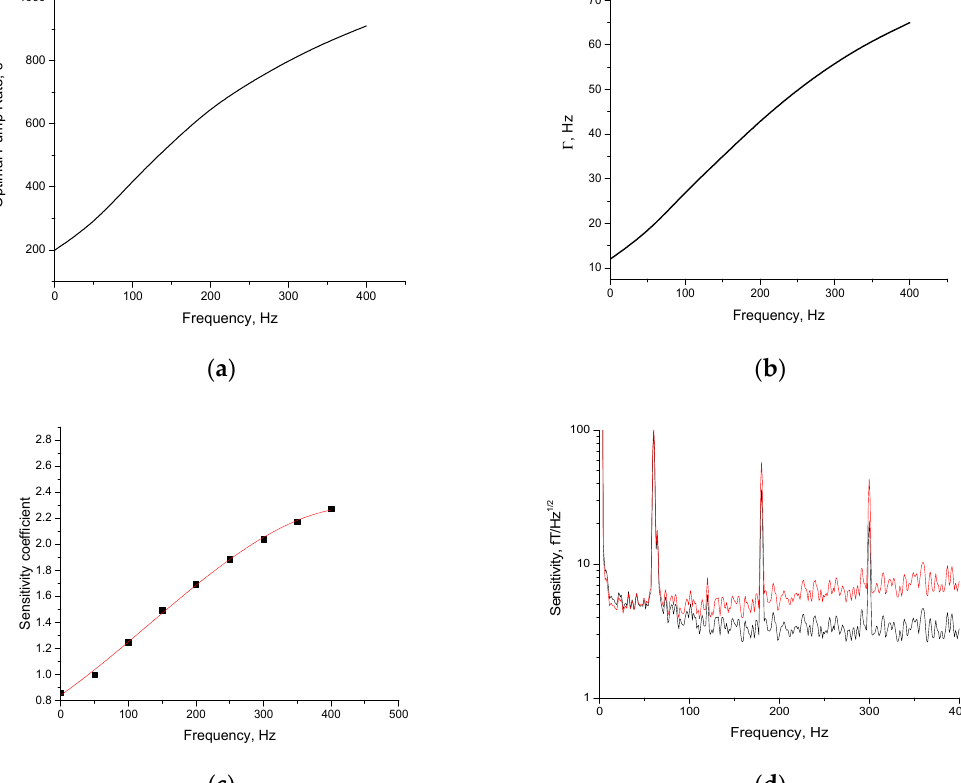
Figure 4. ( a ) The optimal pumping rate for different frequencies which maximizes the atomic magnetometer response and hence sensitivity limited by probe laser noise; ( b ) the magnetic resonance width (bandwidth of the magnetometer) for different frequencies to which bias field is tuned for the optimal pump rate given in ( a ); ( c ) the sensitivity coefficient which is the inverse of the AM response (proportional to P x ∝ qR in Equation (1), where q and Γ are functions of frequency and optimal ( R + R SD ) Γ pumping rate, while the optimal pumping rate is also the function of frequency) to an oscillating field at the center of the magnetic resonance when the bias field is applied and the pump rate is optimized to maximize the response for frequencies in 50 Hz incremental steps; it is normalized to unity at 50 Hz; the fitted polynomial curve f ( ν ) = 0.843 + 0.0036 ν + 5.96 × 10 − 6 ν 2 − 1.55 × 10 − 9 ν 3 for the sensitivity coefficient interpolates the data between the calculated points; ( d ) Sensitivity of AM (red curve) in 0–400 Hz range after multiplying the raw noise calibrated at 50 Hz (black curve) by the AM sensitivity coefficient, accounting for the width and polarization level variation with bias field and optimal pumping rate.